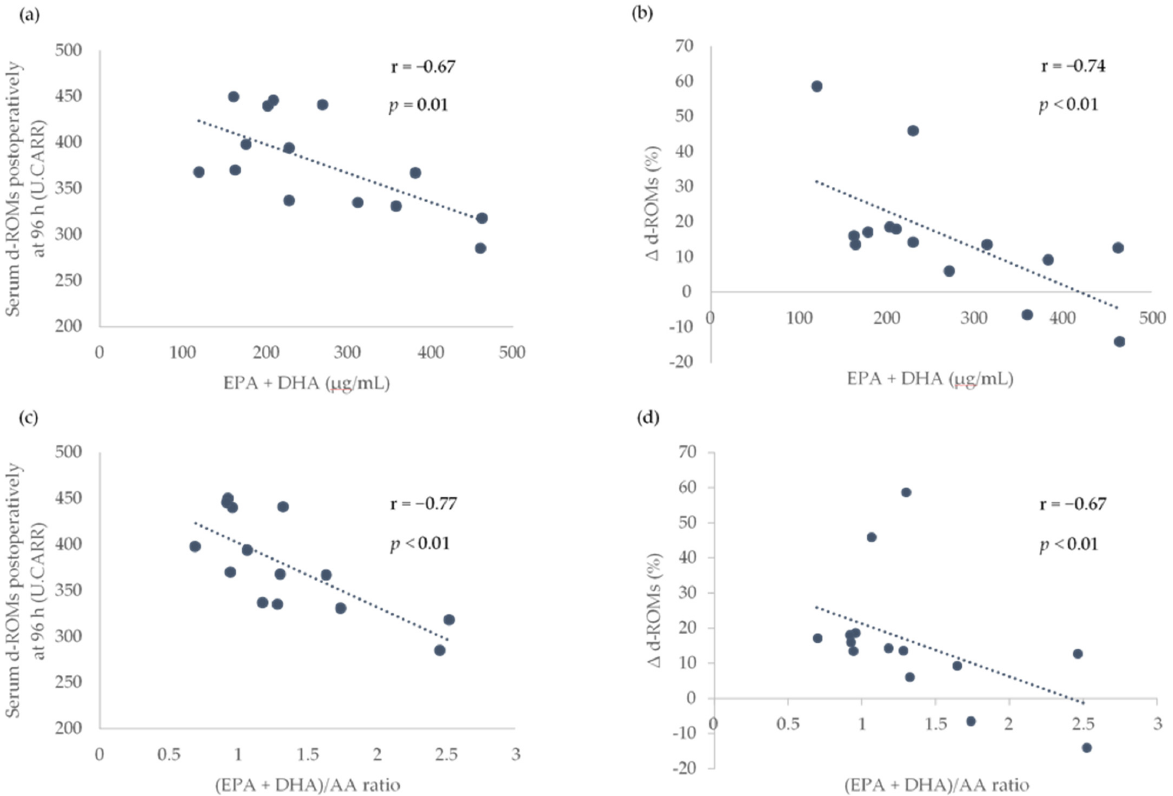
Figure 2. Association of preoperative serum EPA + DHA levels and (EPA + DHA)/AA ratio with the serum d-ROMs